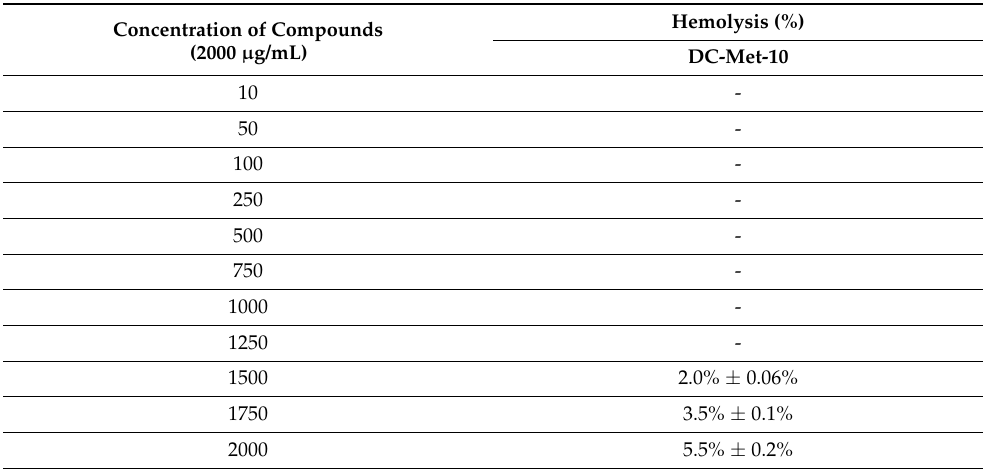
Table 3. Hemocompatibility studies of synthesized amphiphilic molecule (DC-Met-10) at various concentrations ranging from 10 to 2000 µ g/mL.